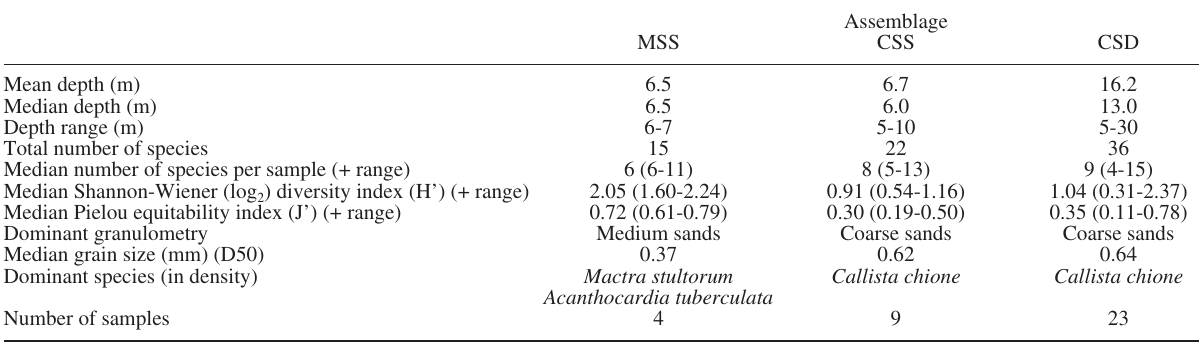
Table 2. – Main characteristics (depth, diversity indexes, granulometry and dominant species) of each identified assemblage. Assemblages: MSS (Medium Sand Shallow), CSS (Coarse Sand Shallow) and CSD (Coarse Sand